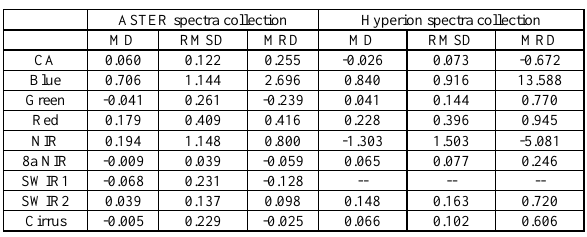
Table 2. Difference measurements of channel reflectance based on the ASTER spectra collection (including 897 spectra) and